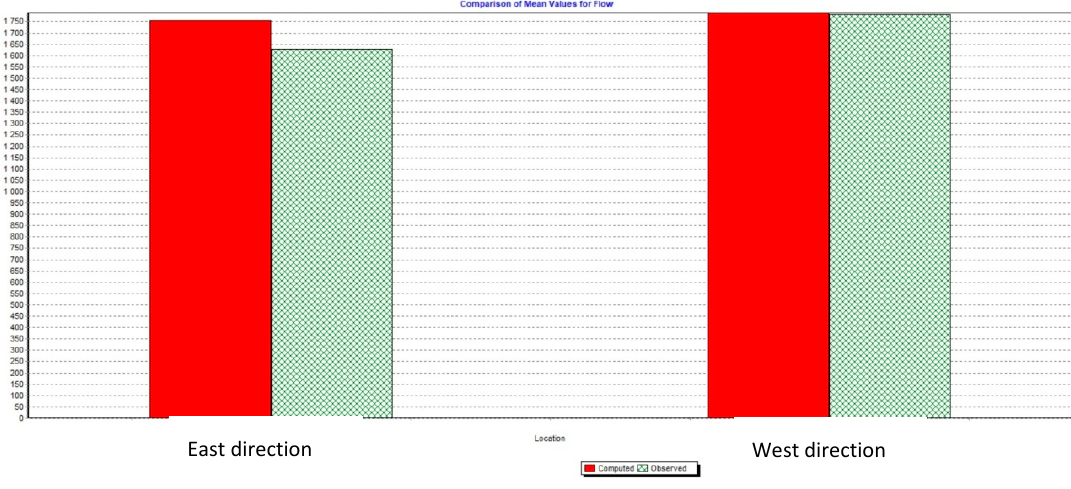
Figure 12. Simulation results for Scenario I.